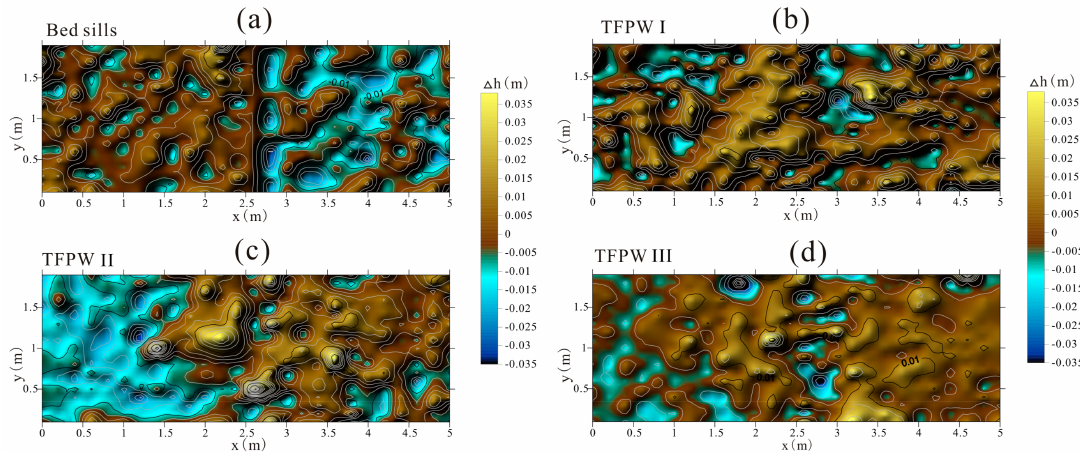
Figure 9. Relative bed elevation changes: ( a ) with bed sills; and ( b – d ) with TFPW I–III, respectively, where the positive values mean deposition and the negative values represent